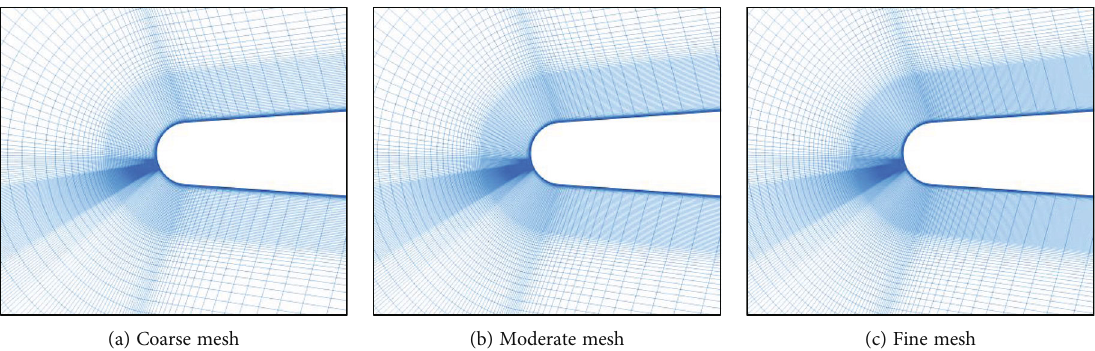
Figure 8: Side view of meshes with di ff erent density.